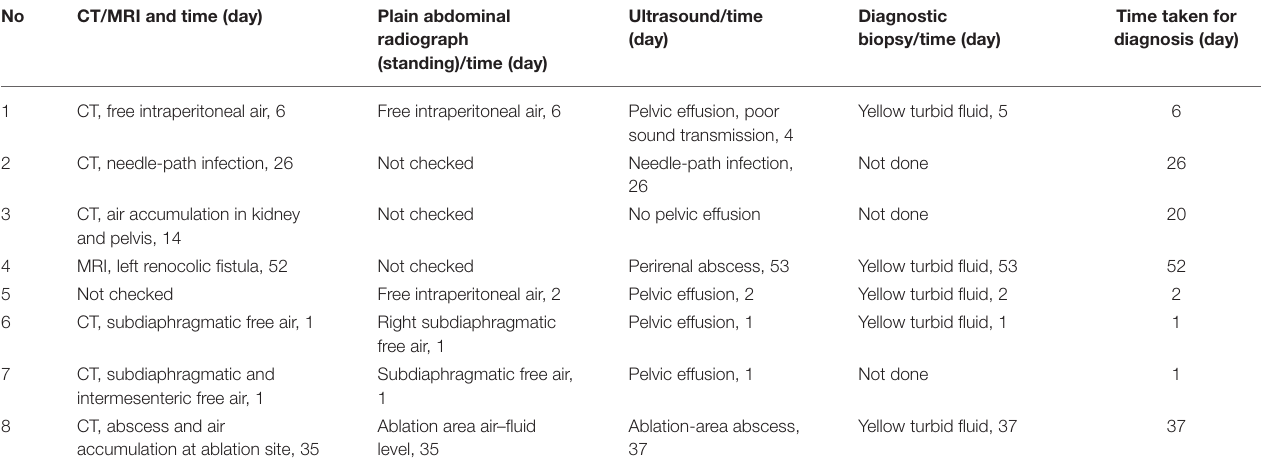
TABLE 4 | Imaging and diagnostic data.